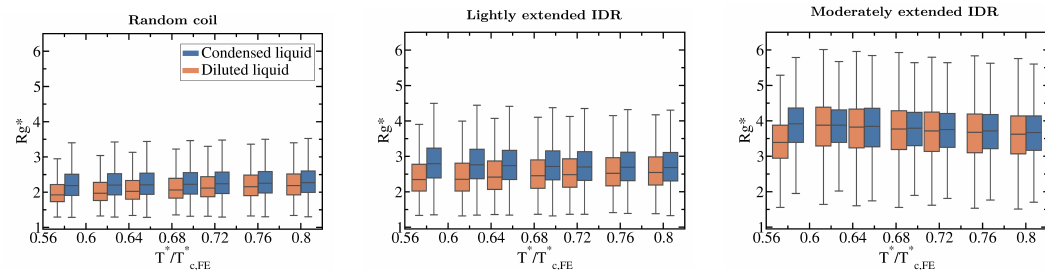
Figure 5. Impact of the liquid–liquid phase transition on the protein conformational ensemble. Boxplots of the radius of gyration vs. normalised temperature ( T ˚ { T ˚ ) for the fully flexible random coil, c , FE and the lightly and moderately extended N = 20 IDRs. Orange boxplots account for R ˚ g in the diluted phase while blue ones for IDRs in the condensed phase. Fully extended IDR boxplots have not been included since R ˚ g is not different in both phases (according to the Kolmogorov-Smirnov test [115]) and does not vary with temperature either as shown in Figure 3C. Boxplots are a 5 number summary of the radius of gyration distribution. The box bounds represent the first and the third quartile of the histograms and the line intersecting the box is the median. The whiskers represent the maximum and minimum values of the